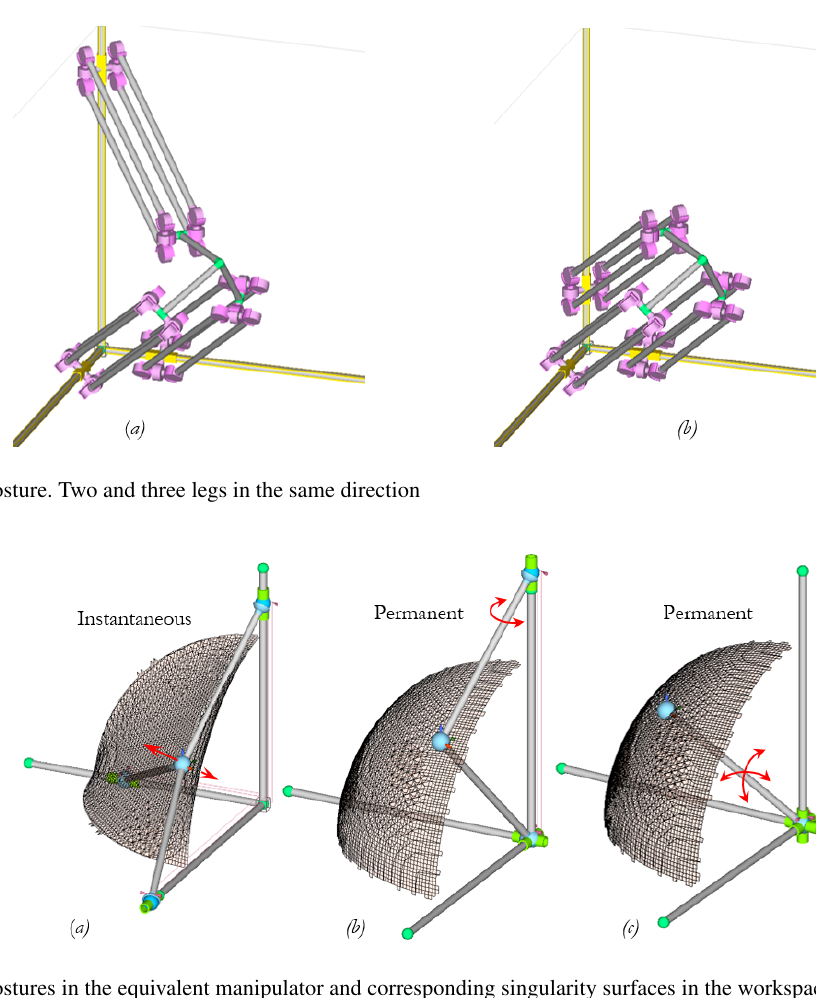
Figure 13. Singular postures in the equivalent manipulator and corresponding singularity surfaces in the